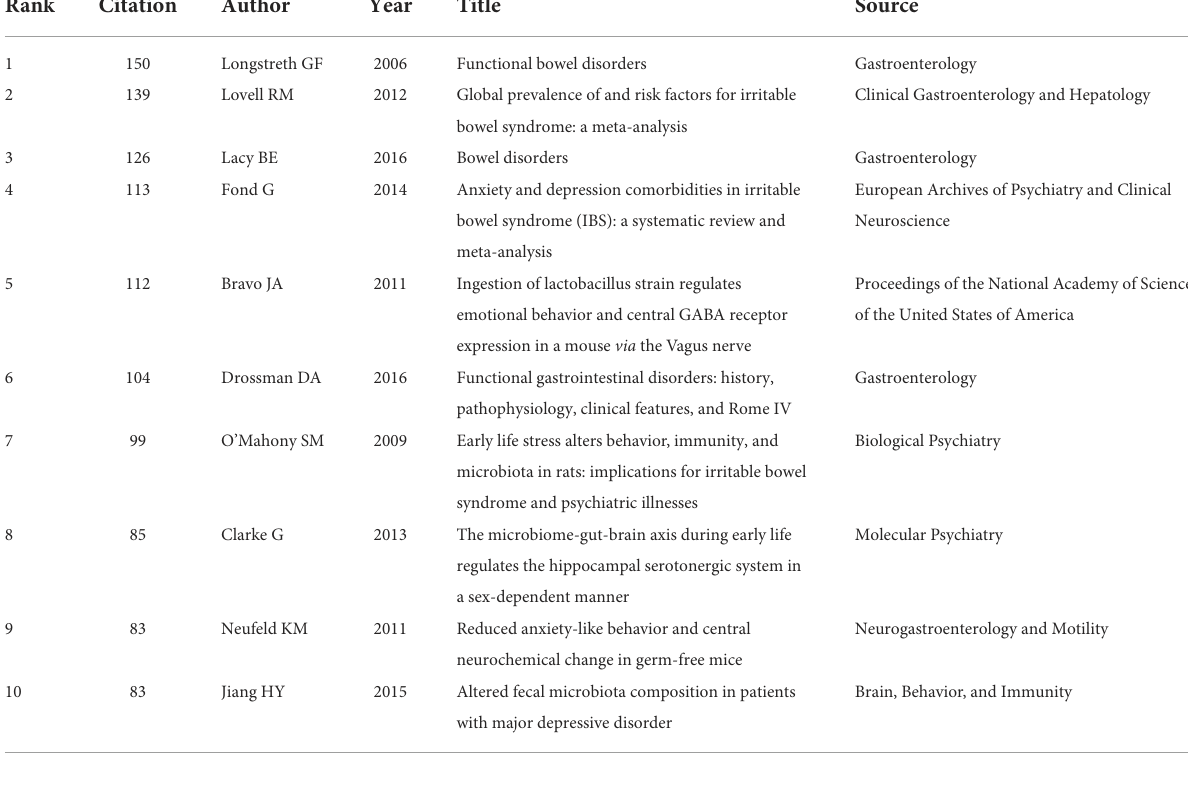
TABLE 5 Top 10 co-cited references on IBS and anxiety/depression.